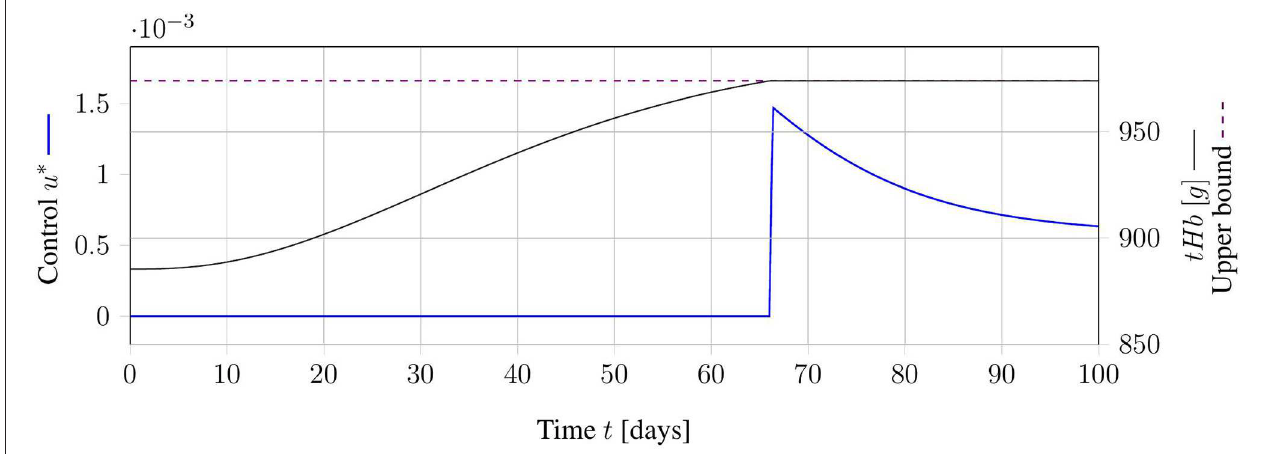
FIGURE 3 | Exemplary result for an optimal relaxed treatment schedule. The continuous control function u (blue) is zero, as long as the tHb -value (black) is below the upper bound (dashed, purple). As soon as the upper bound is reached, the control function increases exactly as much as necessary to keep the tHb -value at the upper bound.